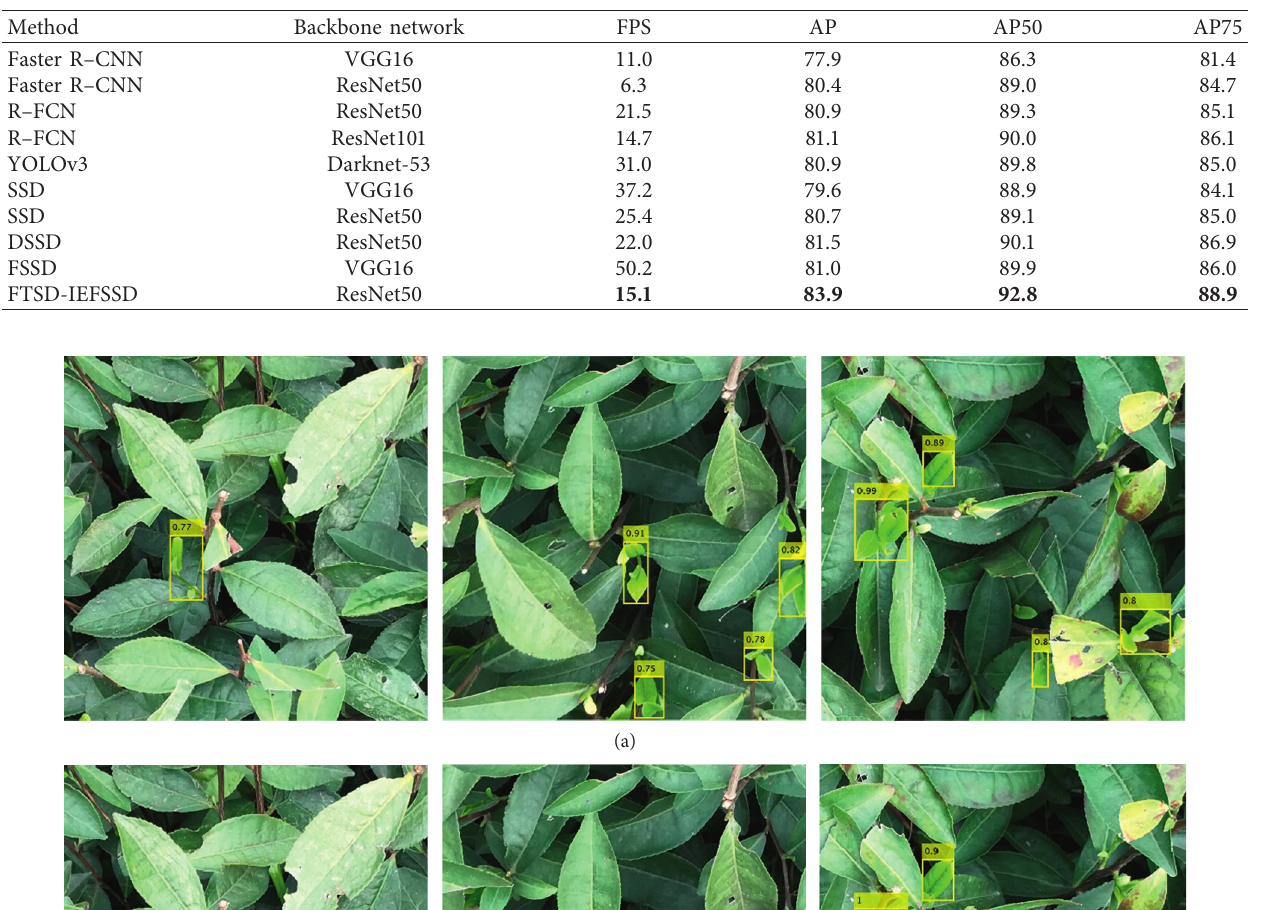
Table 2: Comparisons of different methods for FTSD on the testing